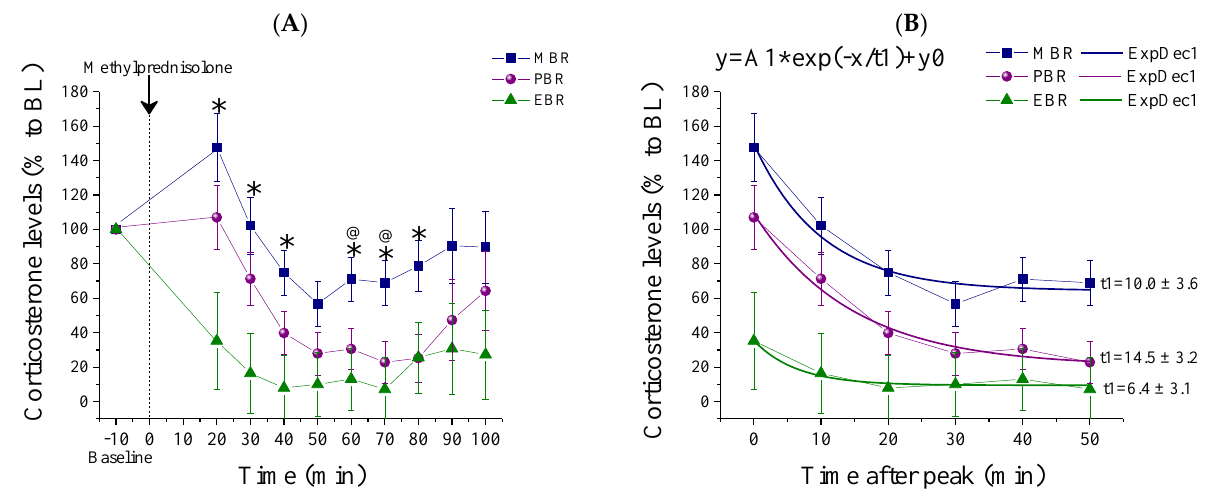
Figure 3. Corticosterone measurements post-MPST. Corticosterone measurements following MPST depicted as percentages from the baseline between the different CBC groups. ( A ) Measurements starting at 10 min before methylprednisolone injection (baseline) and 20 min after methylprednisolone injection, at 10 min intervals over a period of 90 min, points are averaged within each group (* MBR≠ EBR, p < 0.04; @ MBR≠ PBR p < 0.05; mean ± SEM). ( B ) A nonlinear fitting (decay model carried out on the 6 time points following corticosterone peak concentrations indicated significantly different decay constants ( t 1) between groups, such that EBR rats exhibited a slower decay in corticosterone levels than MBR and PBR rats.